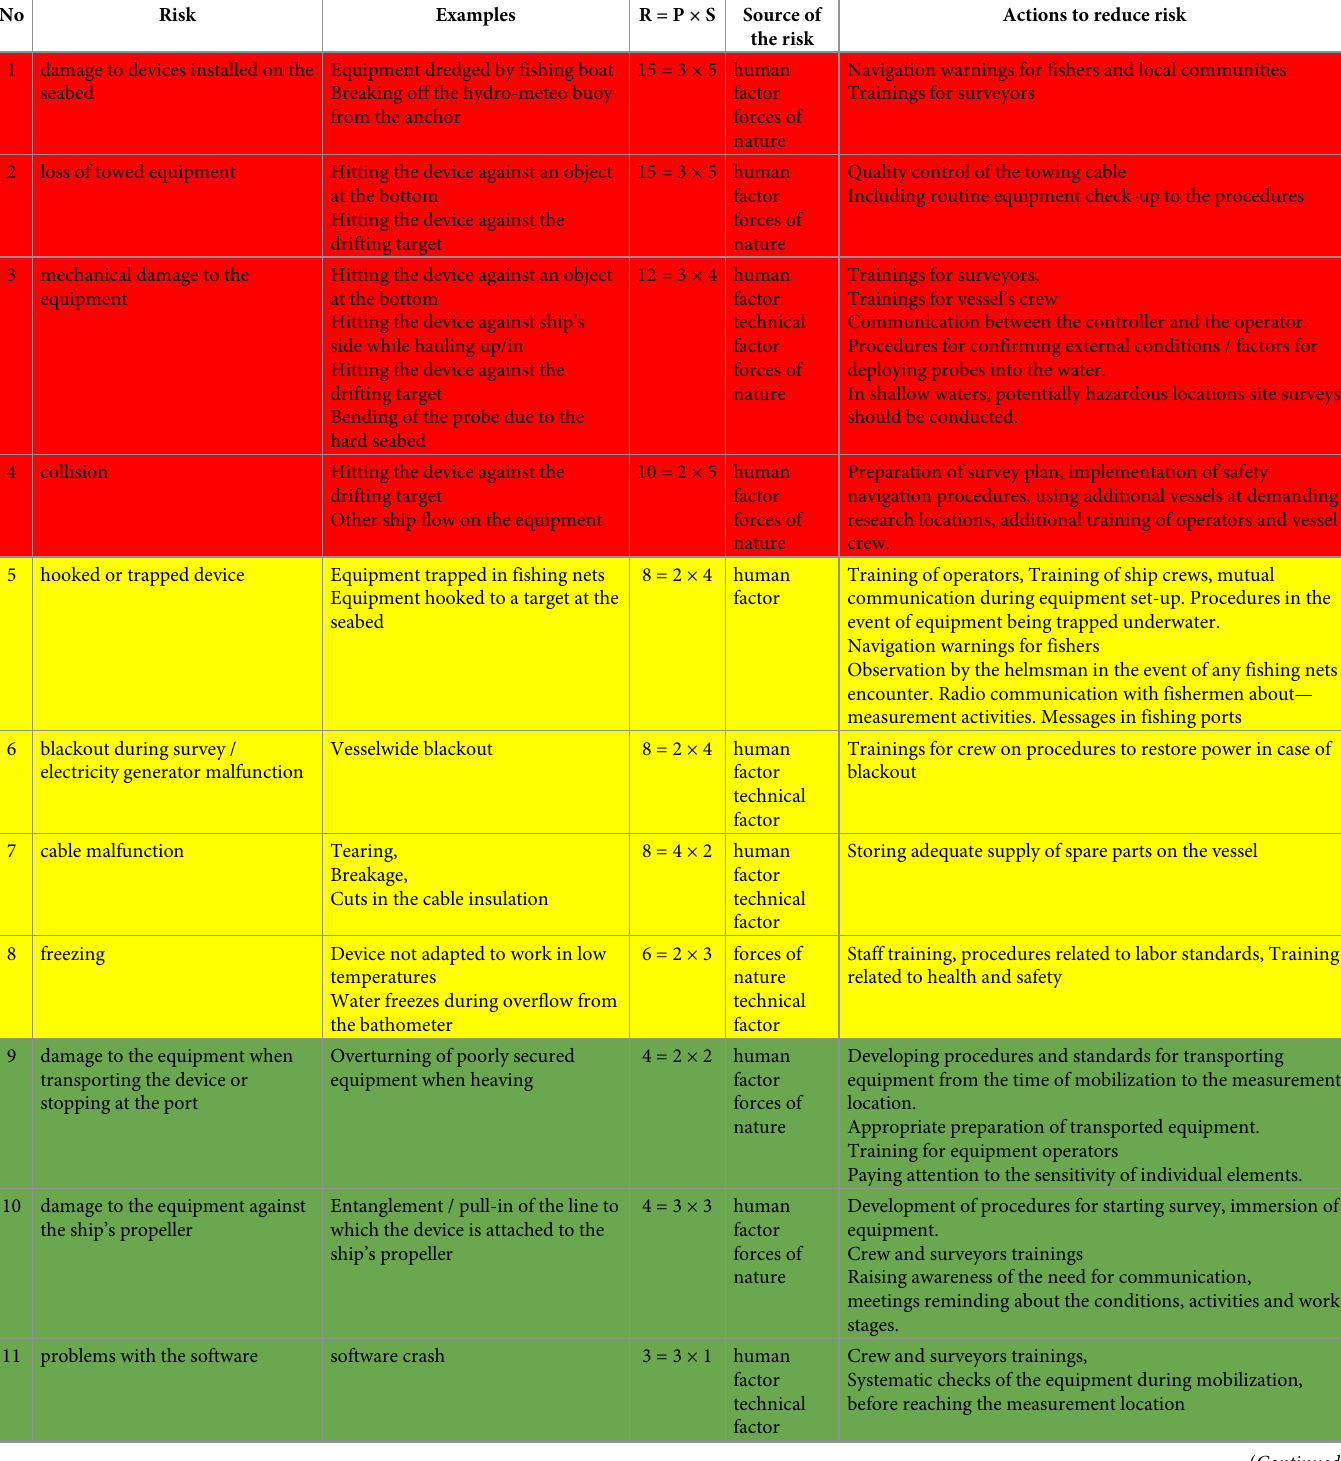
Table 1. Classification of identified risks according to Fig 1 (source: Internal